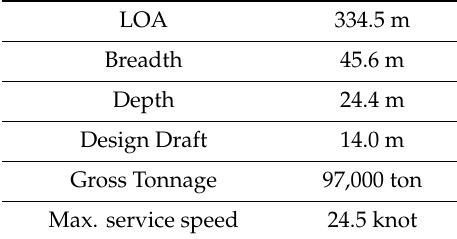
Table 1. Main specifications of the container ship used in this study.